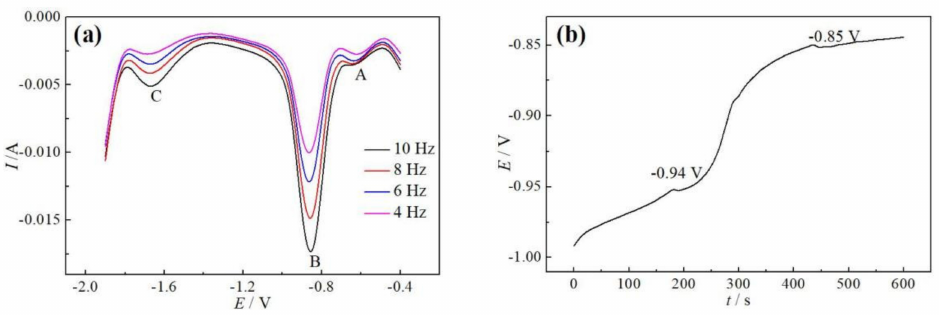
Figure 6. ( a ) SWV curves and ( b ) OCPT curve on Mo electrode ( f : 4~10 Hz, T = 800 ◦